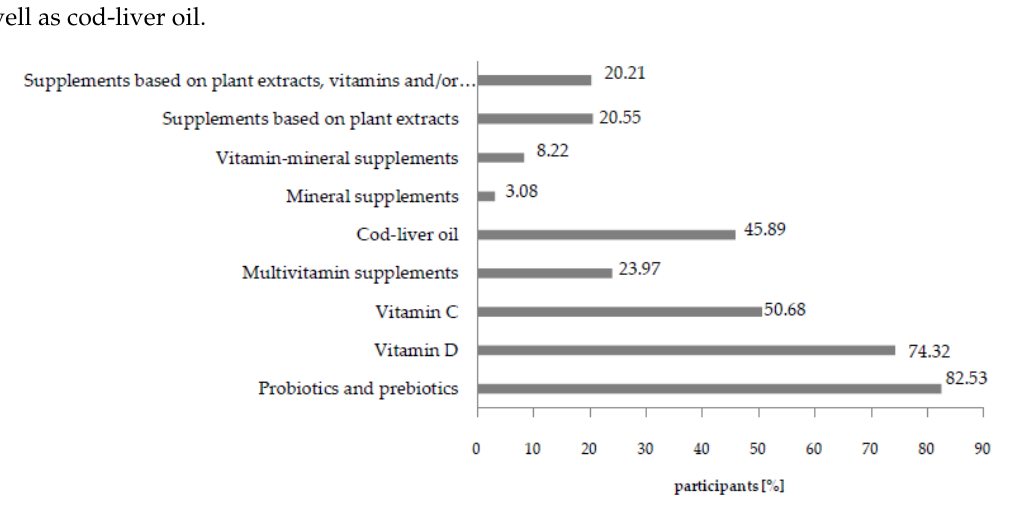
Figure 6. Types of dietary supplements administered to children by caregivers. Percentages add to >100 as participants were able to select >1 reason for us.